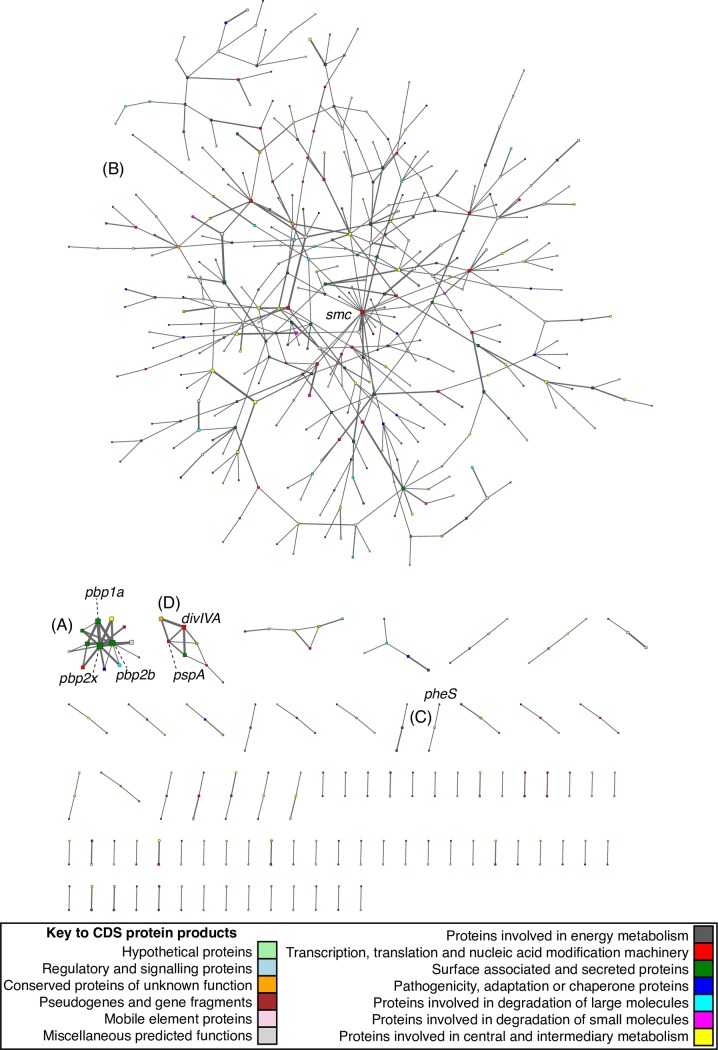
Network of coupled protein coding sequences.This undirected network shows all significant couplings between protein coding sequences (CDSs). Each node is a CDS, colored according to its functional annotation, and scaled according to the logarithm of the number of significant coupled loci it contained. Edges are weighted according to the logarithm of the number of significant coupled loci linking two CDSs. (A) Network component containing the genes pbp2x, pbp1a and pbp2b. (B) Network component containing the smc gene. (C) Network component containing the tRNA synthetase gene pheS and a coding sequence for another putative tRNA-binding protein. (D) Network component containing the genes for pspA and divIVA.